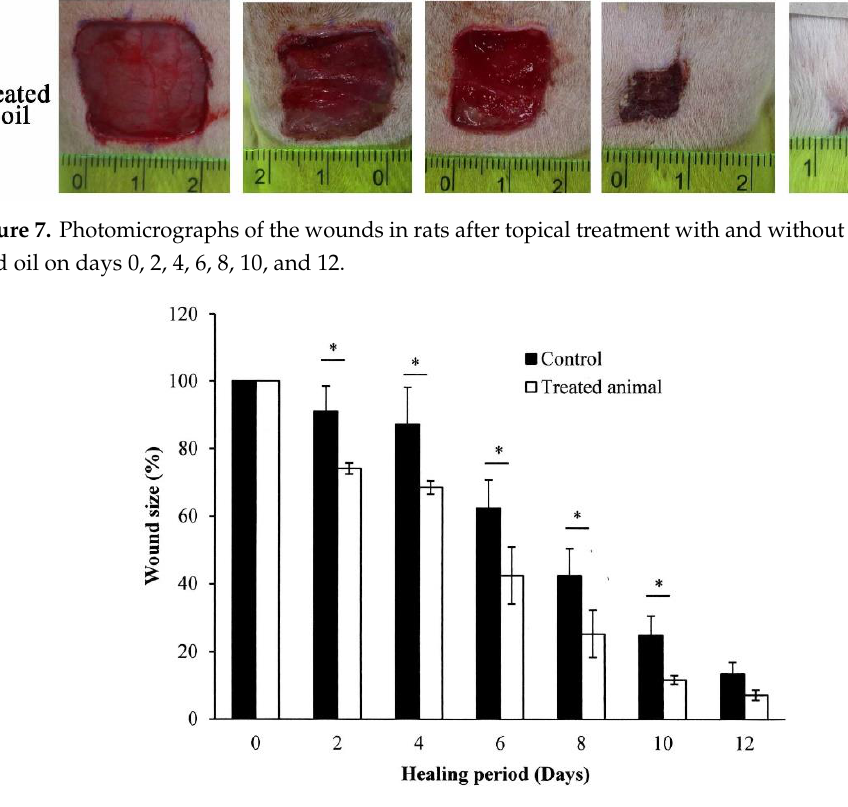
Figure 8. Quantification of the wound size in the rats treated with and without S. mukorossi seed oil. Data are presented as the mean ± SD. * p < 0.05.